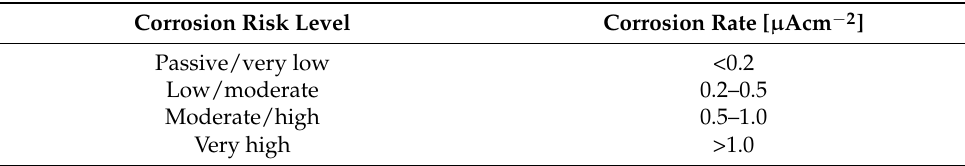
Table 6. Corrosion risk levels classified by the corrosion rate of steel in concrete